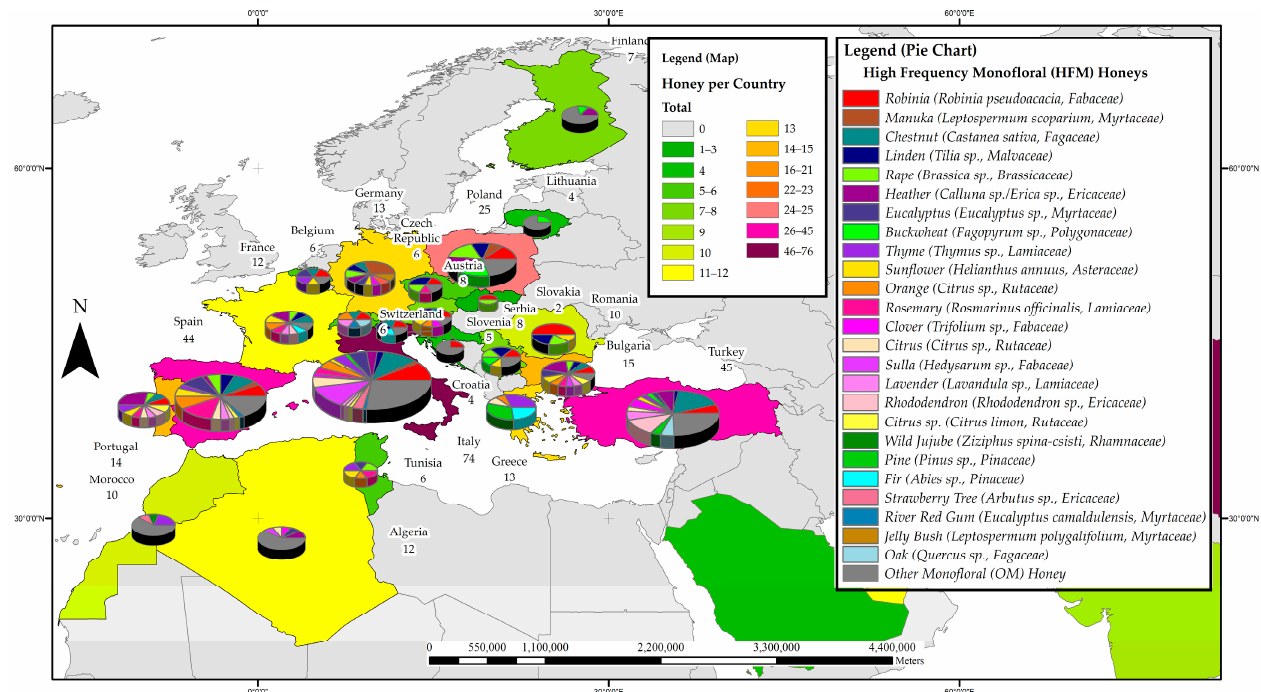
Figure 5. Most frequently studied honeys with respect to their phenolic profile in Africa and Europe.